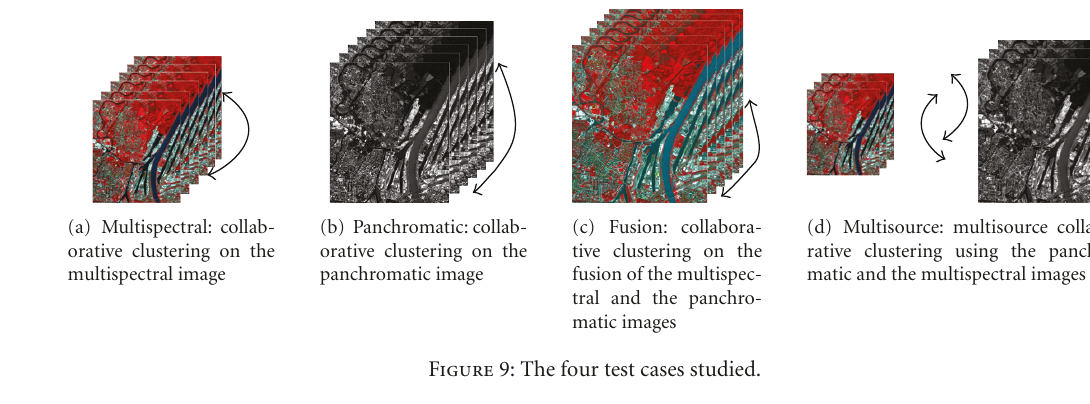
Figure 9: The four test cases studied.